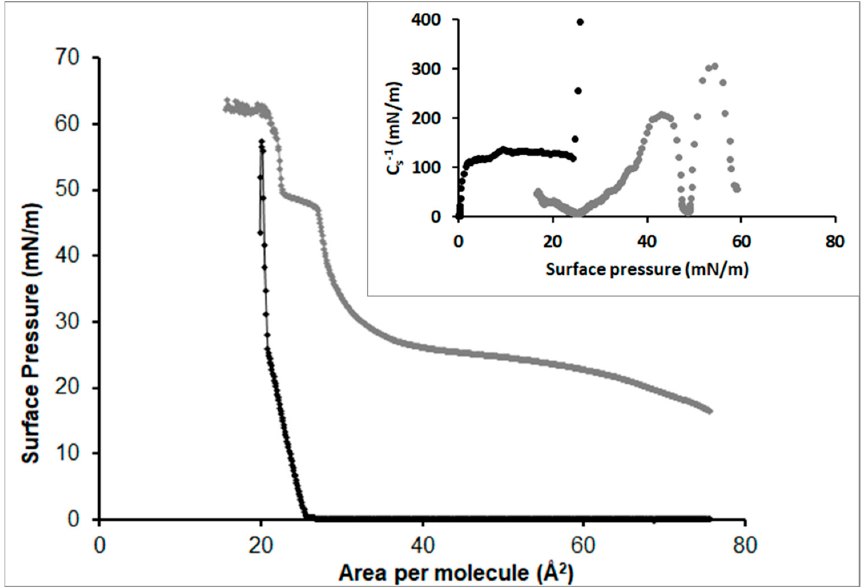
Figure 2. Surface pressure-area isotherms for SA in the absence (black) and in the presence of lysozyme (grey). Inset: Elastic modulus curves from the isotherms of Figure 2 for SA in the absence (black) and in the presence of lysozyme (grey).